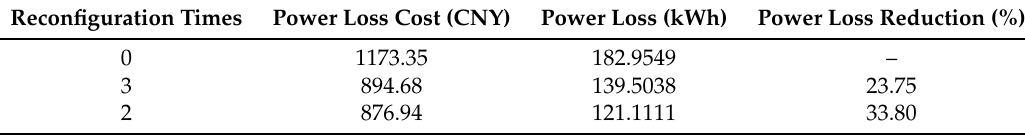
Table 5. The mean cost and power loss under normal and dynamic